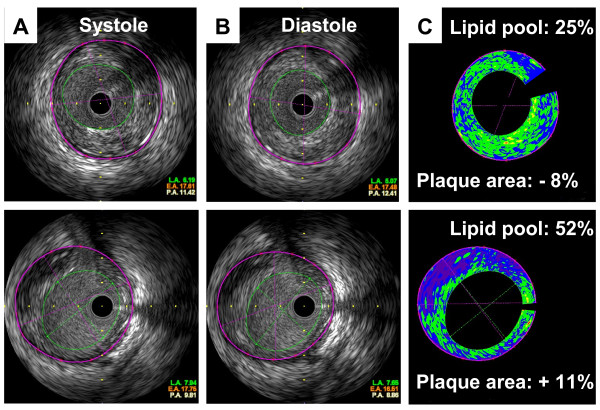
 Intravascular ultrasound images of coronary arteries. (A) Gray scale images in systole. (B) Gray scale images in diastole at the same site as (A). (C) Integrated backscatter intravascular ultrasound images at the same site as (A) and (B). (Upper) Representative cross-sectional images that showed reduction of plaque area from diastole to systole. (Lower) Representative cross-sectional images that showed increment of plaque area from diastole to systole.